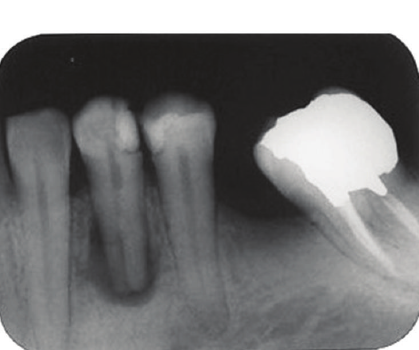
Figure 1: Periapical radiograph of mandibular left first premolar revealing complex root canal system.